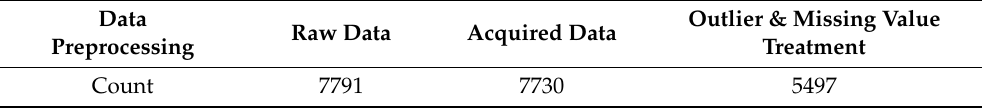
Table 2. Results of data preprocessing.